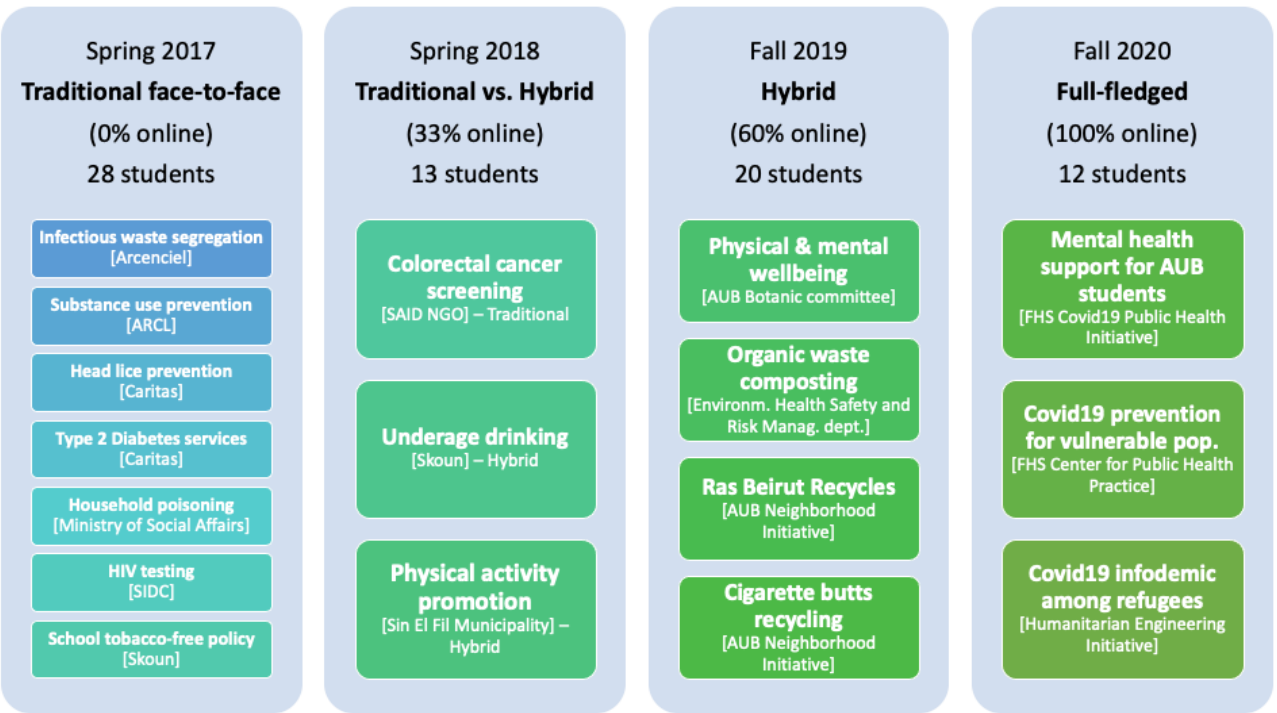
Figure 1. Characteristics of four iterations of the course and topics addressed.